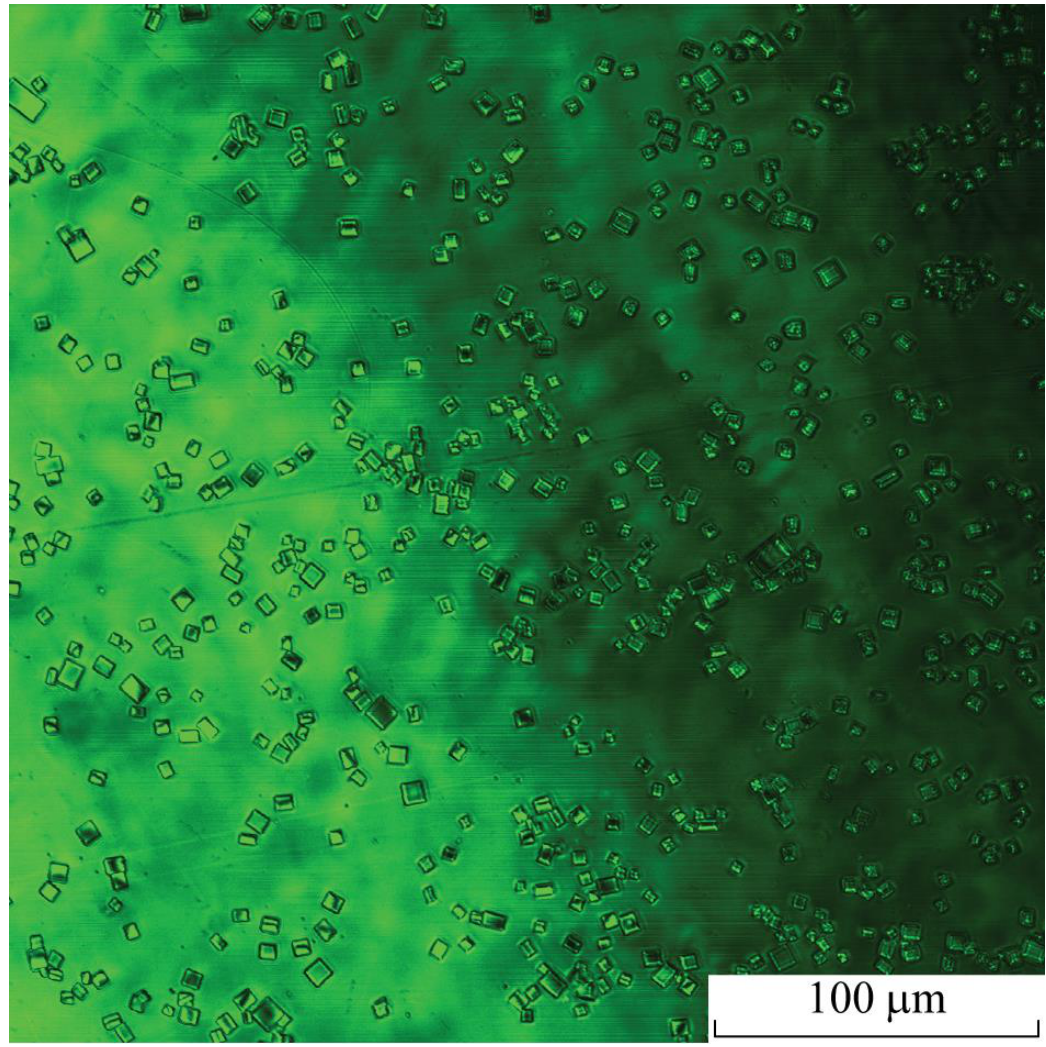
Figure 5. Single cubic crystals of xenon hydrate (5–25 μm); observed at +4.0 °C, 2.3 atm.